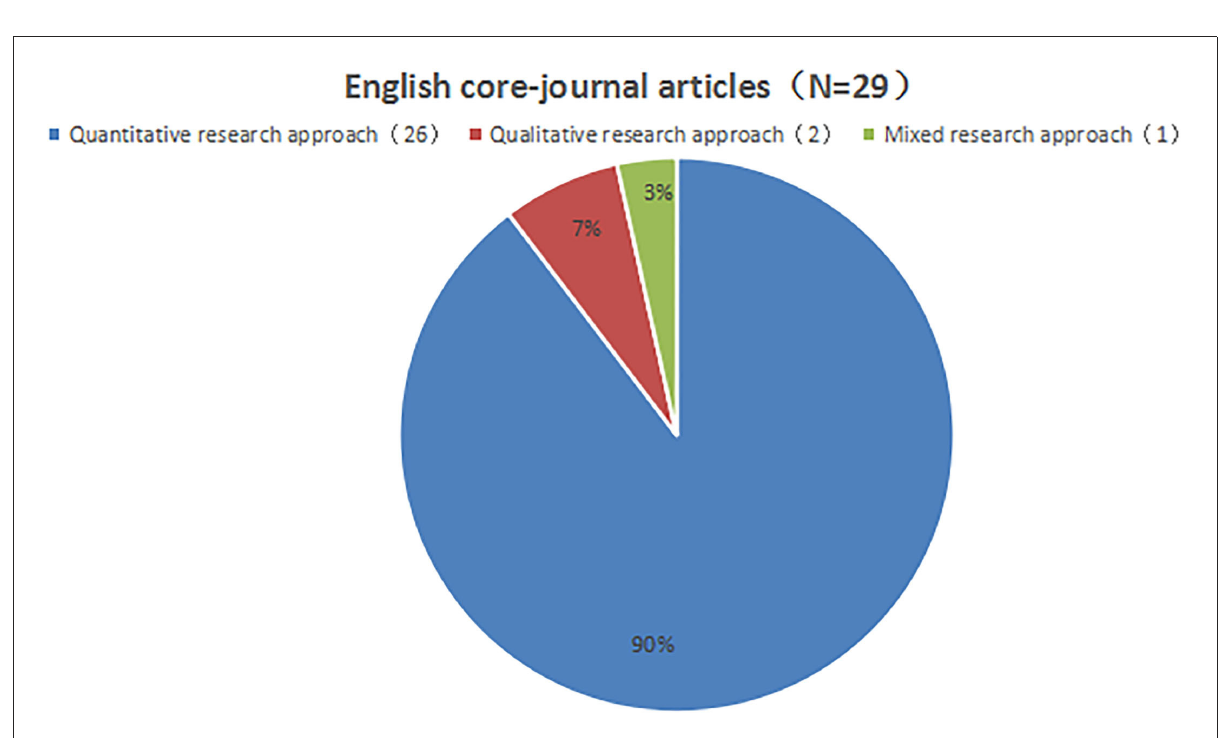
FIGURE5 Proportion of research methods in English core-journal